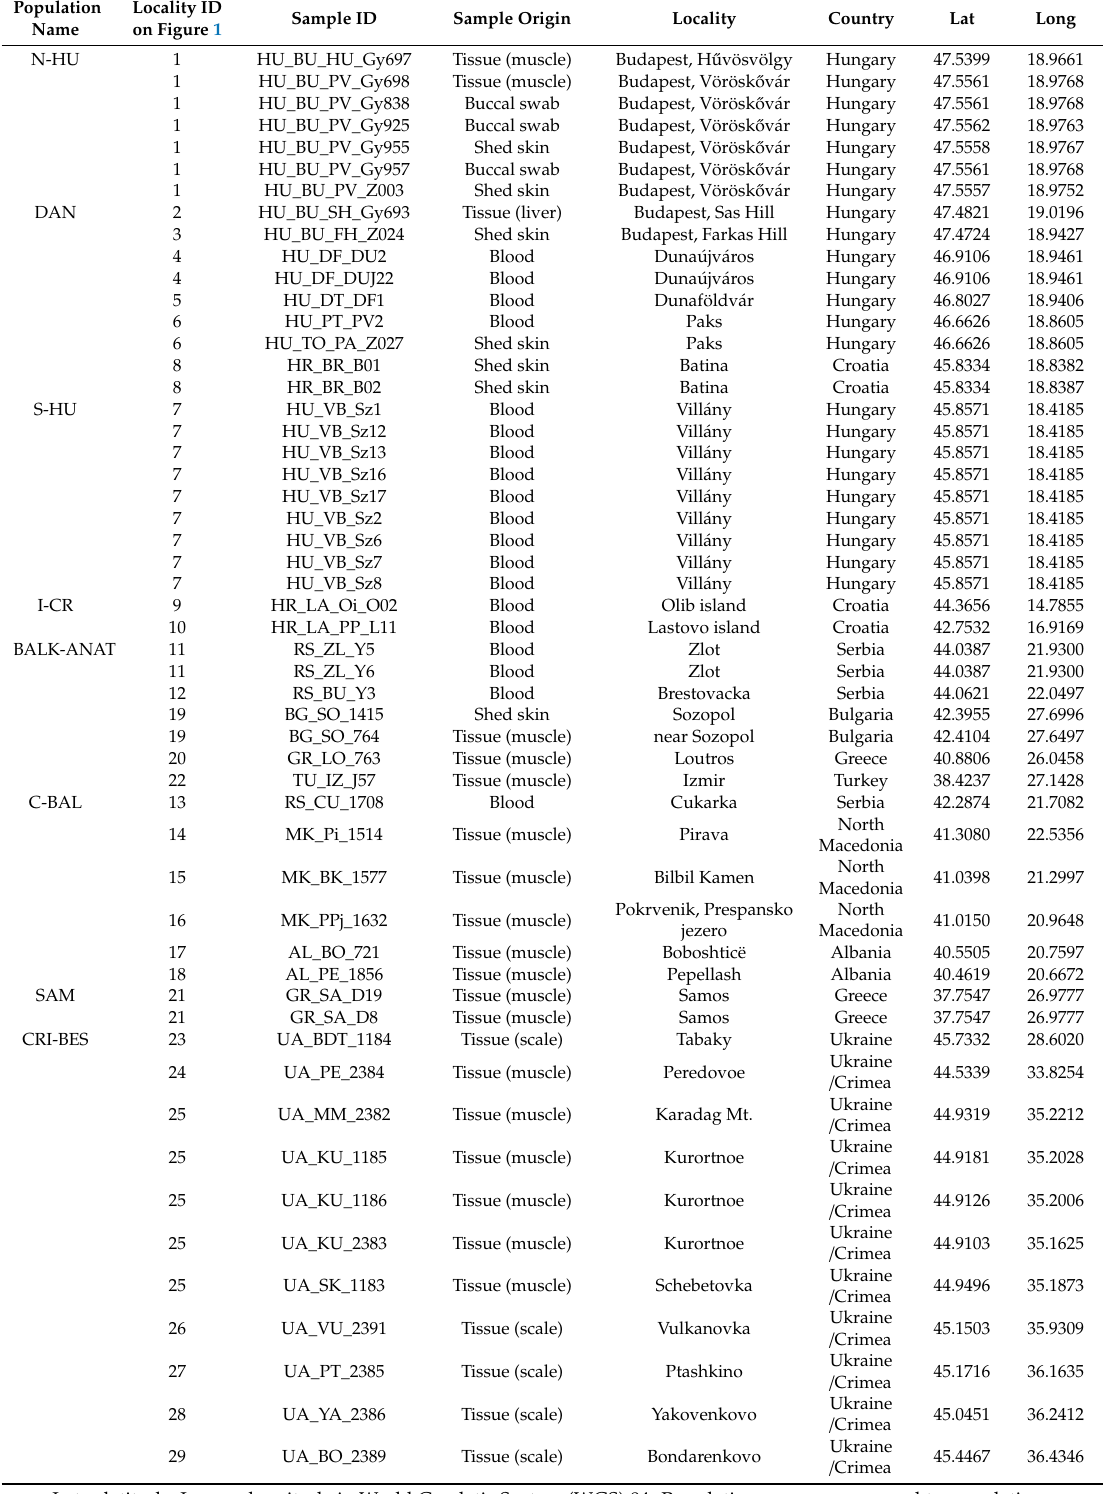
Table 1. Information on the D. caspius individuals analyzed in this study. Population name, locality ID corresponding to Figure 1, Sample ID, sample origin, locality, country, and WGS 84 geocoordinates are